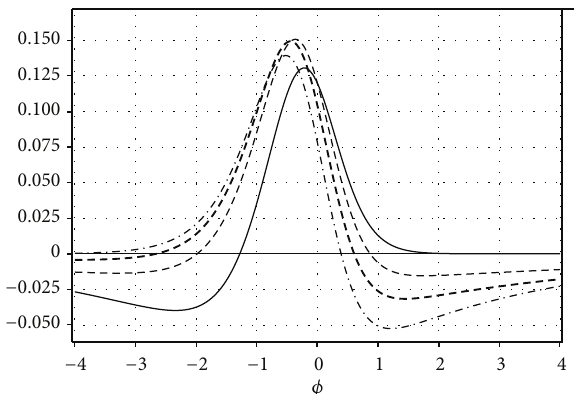
Figure 6: The energy density given by (21) for 𝑐 = −1/2 (solid line), 𝑐 = −1/4 (long dashed line), 𝑐 = −1/8 (dashed line), and 𝑐 = 0 (dot-dashed